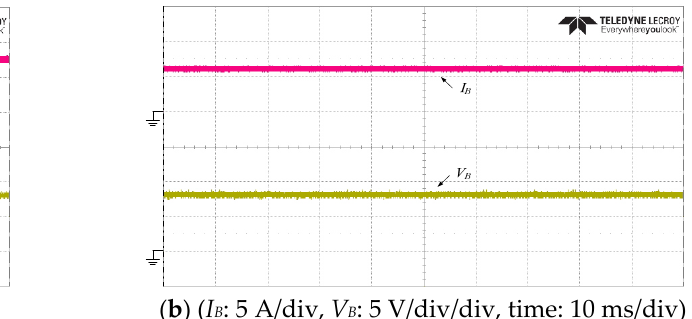
Figure 16. Measured battery voltage V B and current I B waveforms: ( a ) under I B = 3 A and ( b ) under